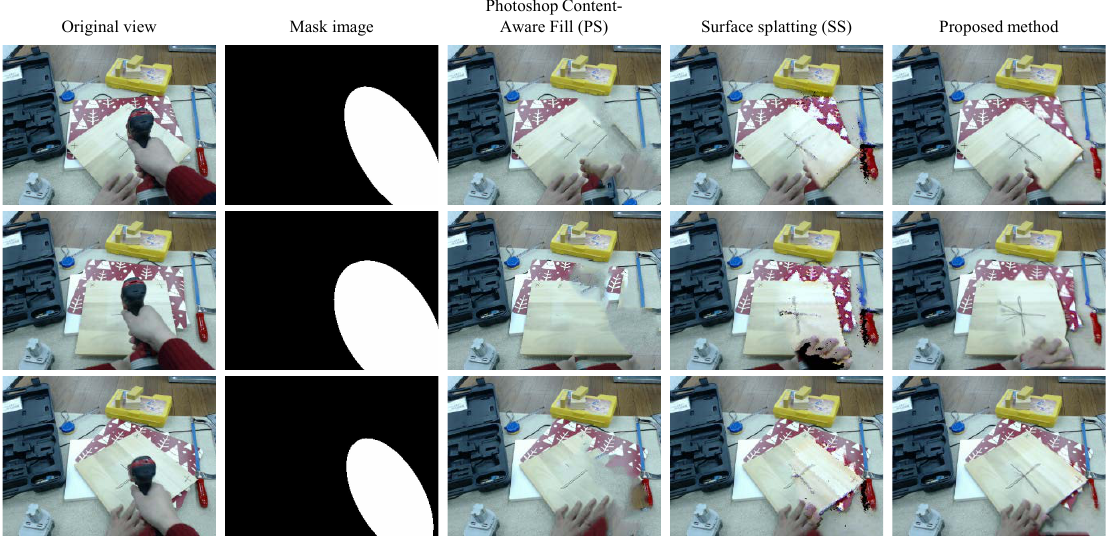
Figure 4. Qualitative comparison of original view and DR methods provided from Photoshop Content-Aware Fill, surface splatting, and the proposed